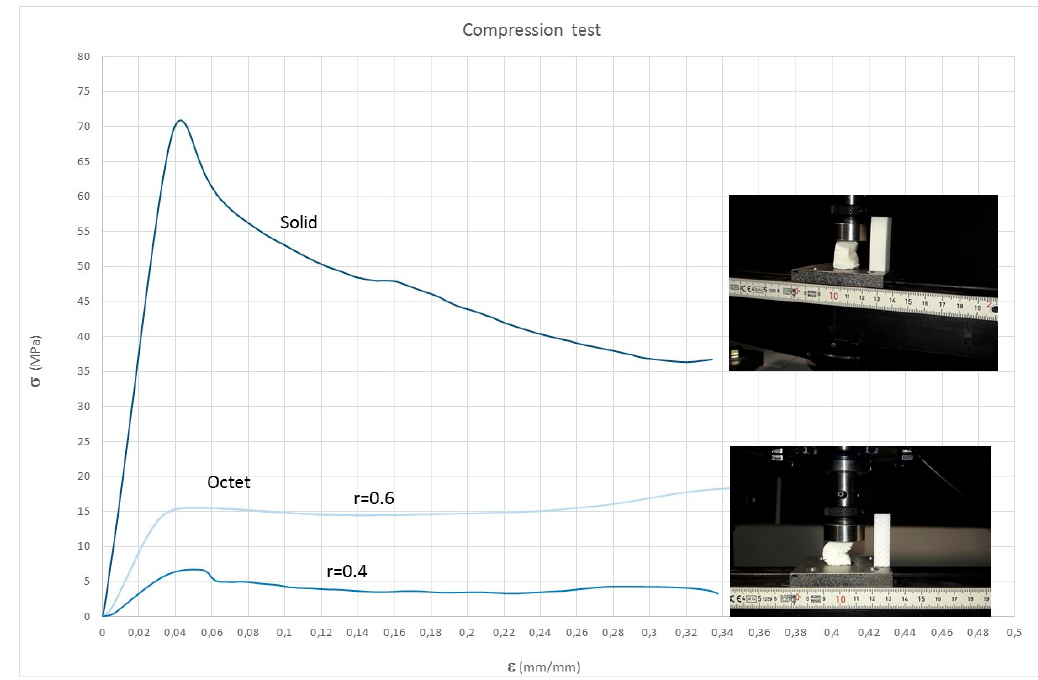
Figure 7. Stress–strain curves of the octet-truss structures and the solid-printed structures, up to the final densification.